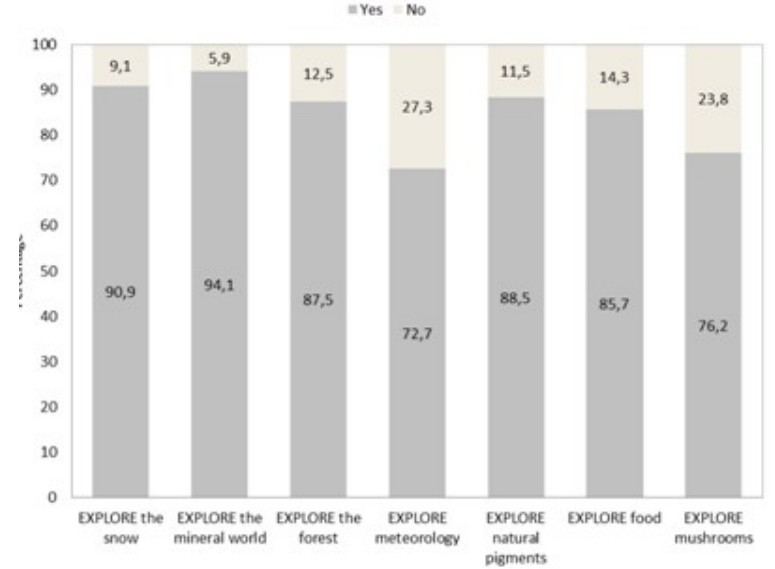
Figure 4. Percentage of responses to the queston: "Will you apply some of the EXPLORE course contents to your